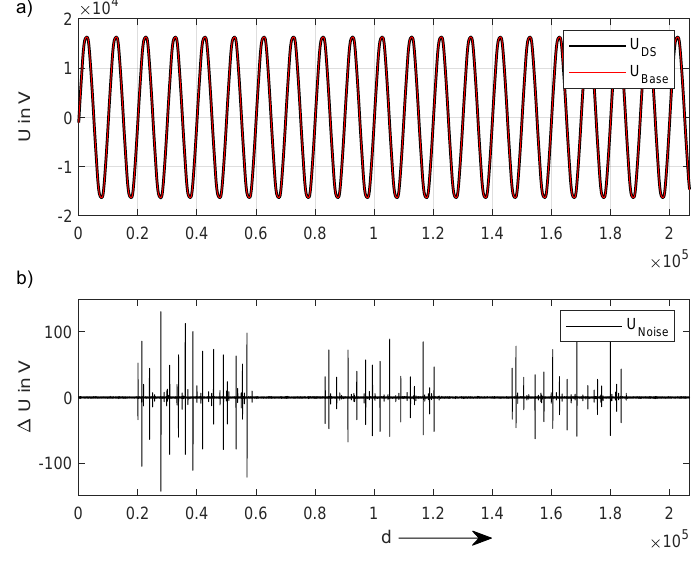
Figure 6. Overview of U DS and generated U Base ( a ) and U Noise ( b ).